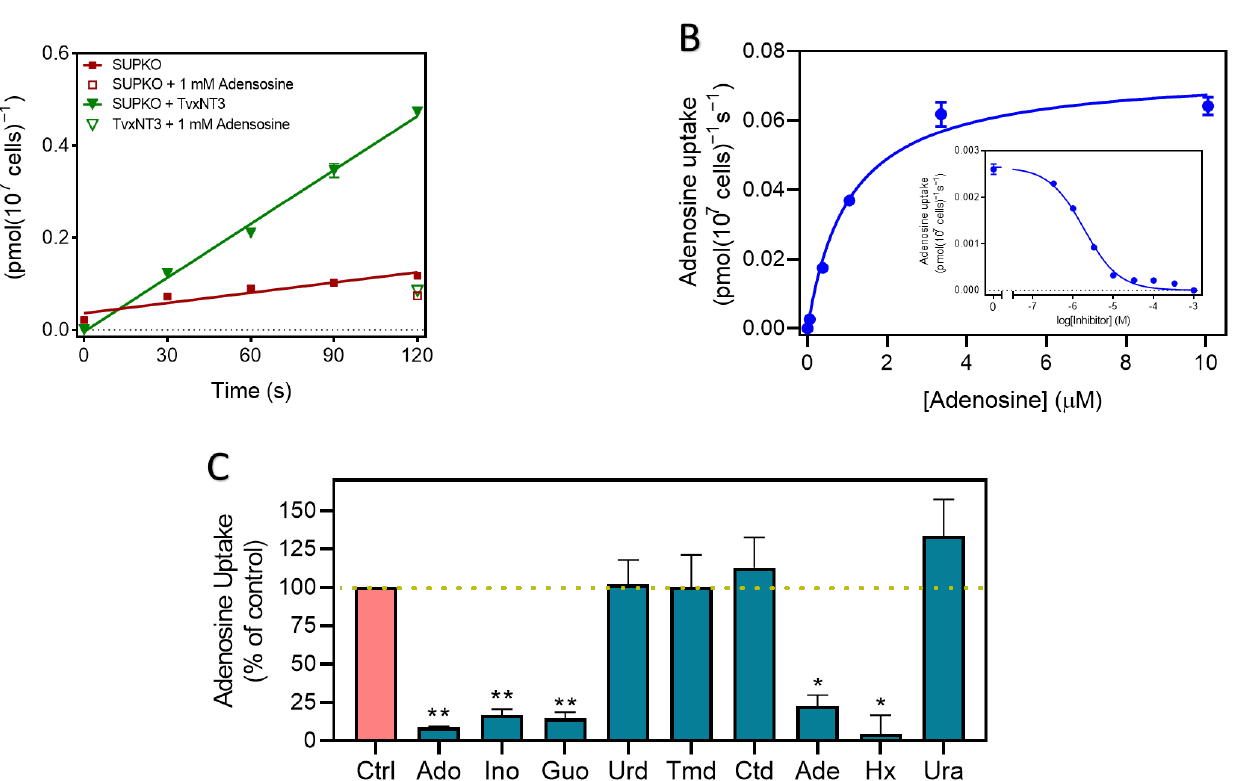
Figure 5. [ 3 H]-adenosine (0.05 µ M) uptake by TvxNT3 expressed in SUPKO. ( A ) Uptake over 120 s compared to control, and ( B ) Uptake in the presence of 0–1 mM unlabeled adenosine. ( C ) Adenosine uptake in SUPKO+TvxNT3 in the presence of unlabeled nucleosides and nucleobases. Purine and pyrimidine nucleobases and nucleosides at 100 µ M competed with 0.05 µ M of [ 3 H]-adenosine for transport through TvxNT3. Figure shows the average of three independent experiments, each carried out in triplicate (% adenosine uptake average ± SEM, n = 3). Statistically significant difference from the control was determined by an unpaired, two-tailed t -test; *, p < 0.05; **, p < 0.01.